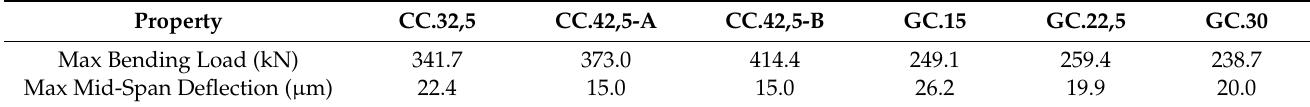
Table 5. Maximum mid-span deflection and bending load.